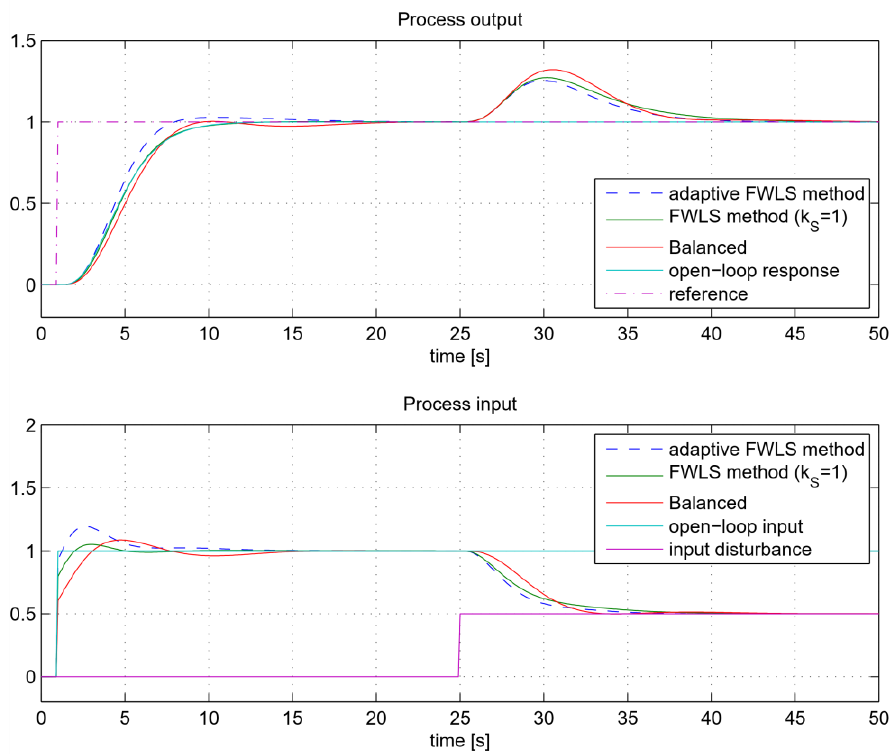
Figure 27. The closed-loop tracking and control signals for process G P 7 when using FLWS, adaptive FLWS and Balanced method.